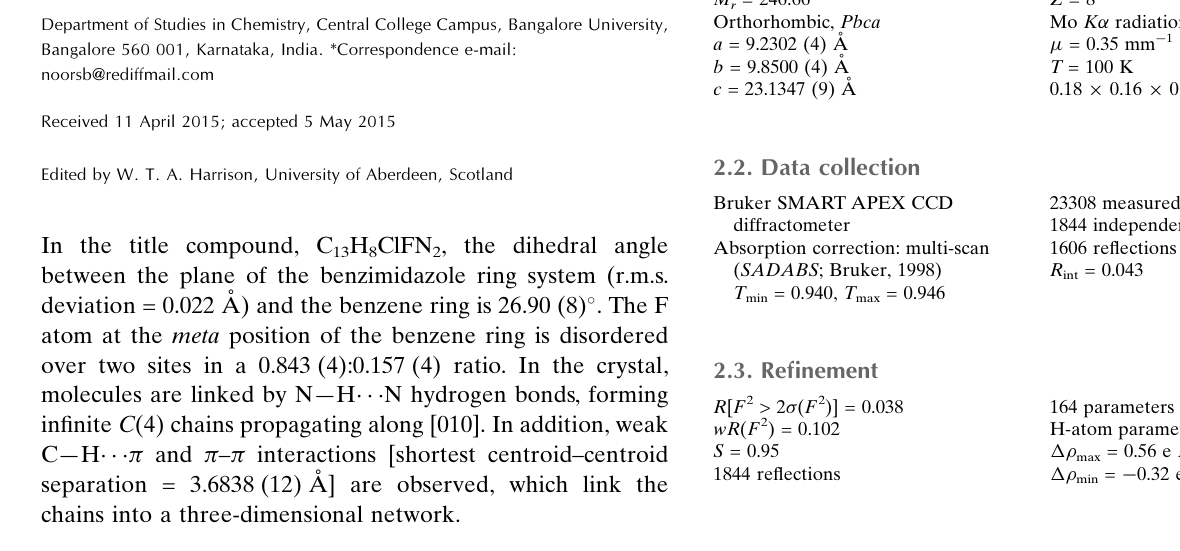
Hydrogen-bond geometry (A˚ , (cid:2)